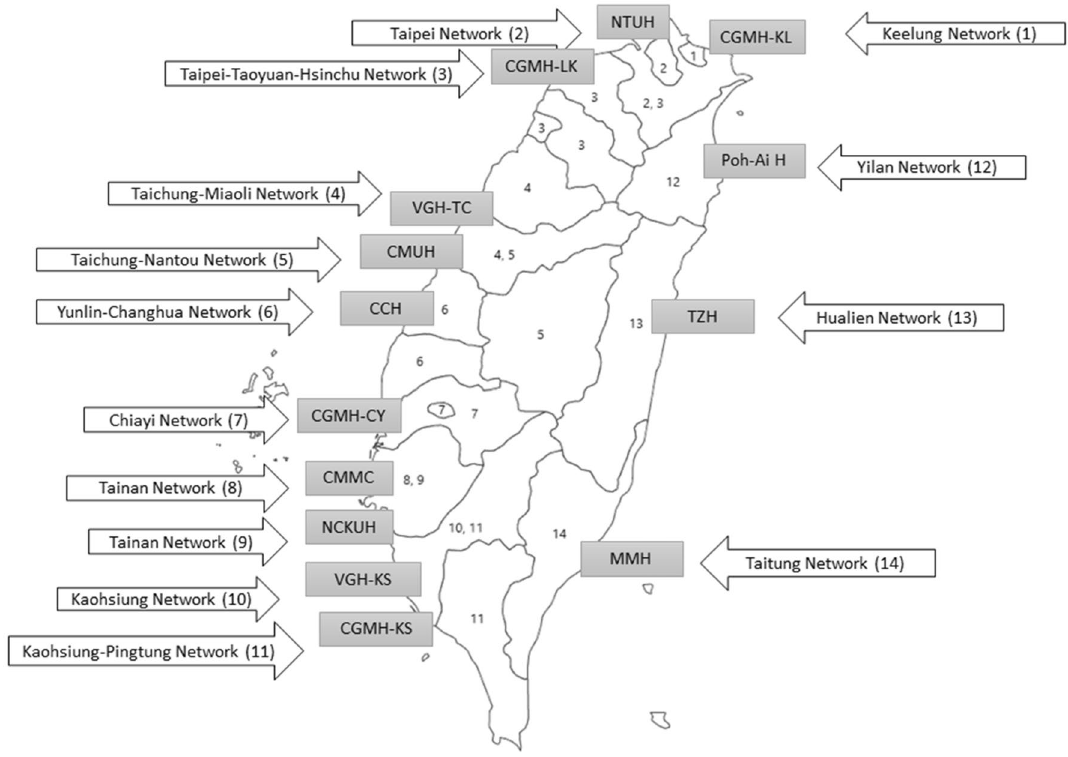
Figure 1. The 14 emergency care referral networks designated by the Ministry of Health and Welfare of Taiwan. Each of the 14 referral networks has a base hospital, which is highlighted in gray. The figure was created using Microsoft PowerPoint 2019 (www. micro soft.